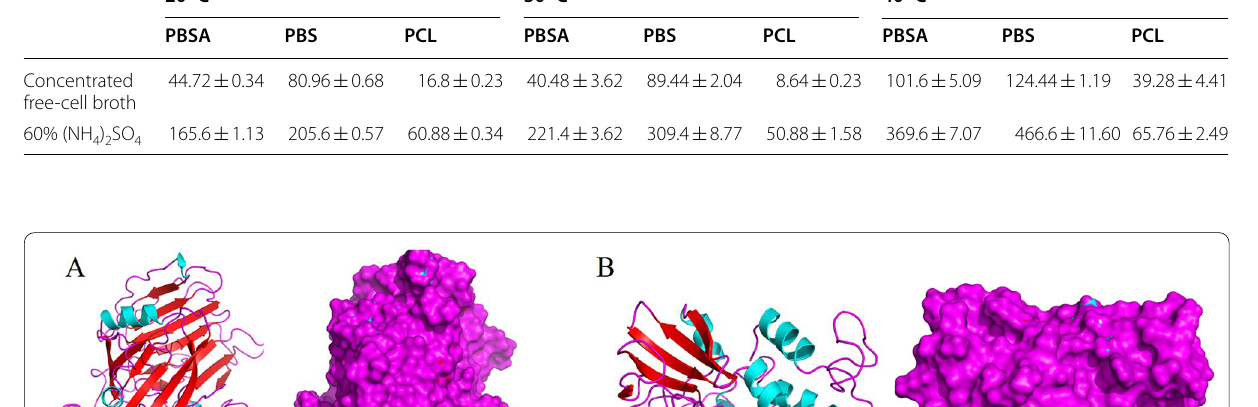
Table 2 Biodegradation activity of free-cell broth after concentration and precipitation with (NH and PCL at different temperatures expressed in U/mL measured in turbidimetric assay. The experiment was performed in duplicate 20 °C